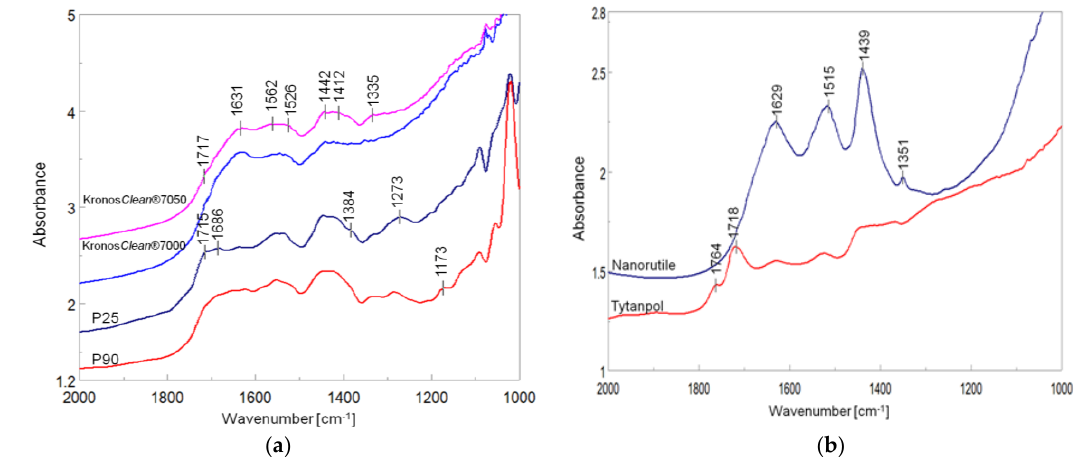
Figure 14. FTIR spectra of titania samples after photocatalytic decomposition of acetaldehyde, ( a ) Kronos and Evonik and ( b ) rutile.